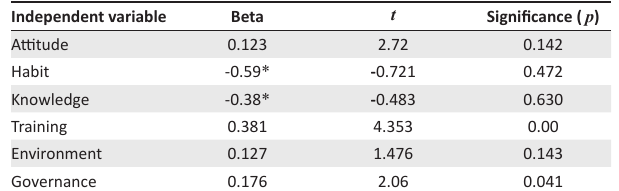
TABLE 5: Multiple regression analysis.